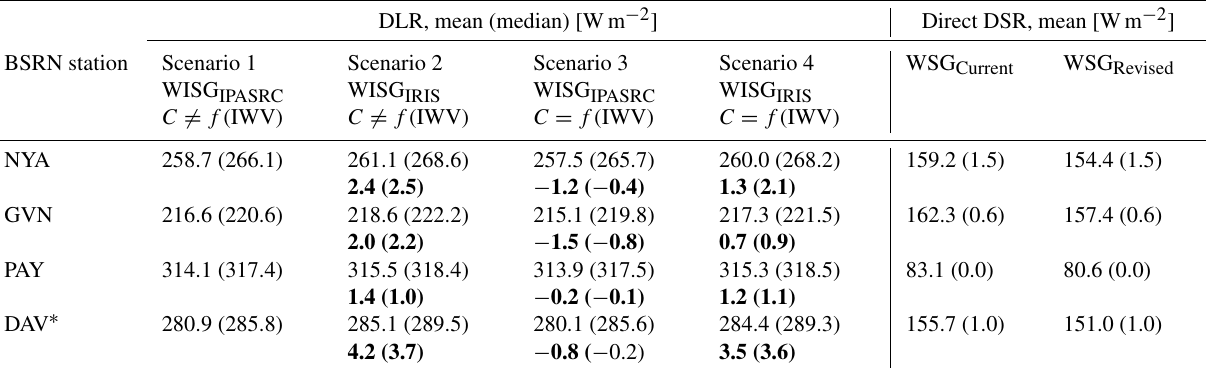
Table 4. Mean and median (in brackets) values of the 2006–2015 all-sky DLR and direct DSR time series for three BSRN (NYA, GVN and PAY) stations using time series from the BSRN archive and for Davos (not a BSRN station). Four scenarios are shown where (i) the term “WISG IPASRC ” or “WISG IRIS ” refers to a WISG calibration based on the IPASRC campaigns or IRIS pyrgeometers, respectively, and (ii) the pyrgeometer sensitivity ( C ) is either a function or not a function of IWV. Scenario 1 represents the current BSRN archived time series using current PMOD/WRC sensitivity values. Bold numbers represent the difference in mean and median (in brackets) DLR values with respect to scenario 1. Direct DSR median values are close to zero as a result of night-time measurements being included in the time series